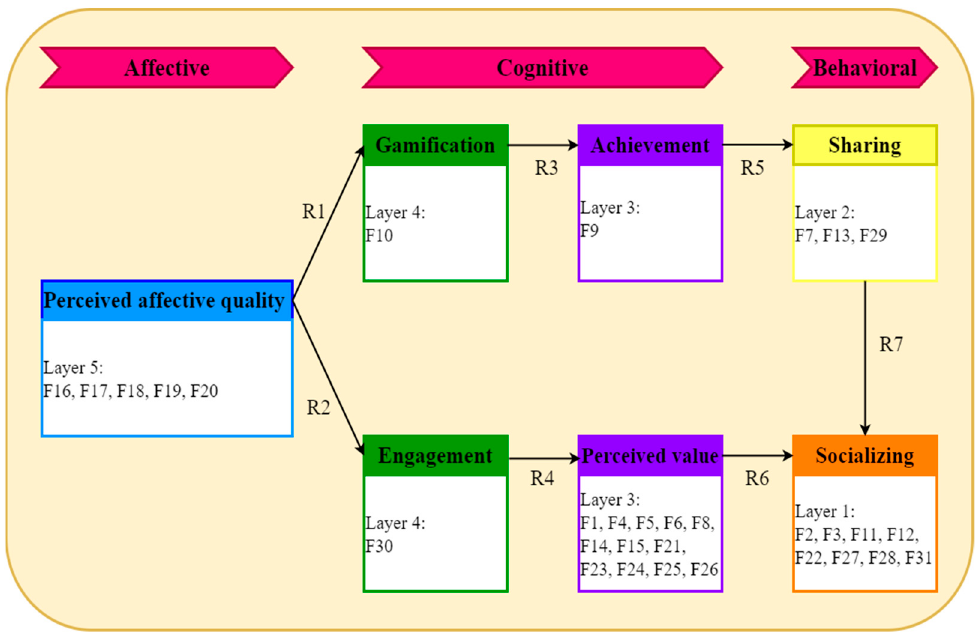
Figure 6. Proposed theoretical relationships of the 31 enablers.